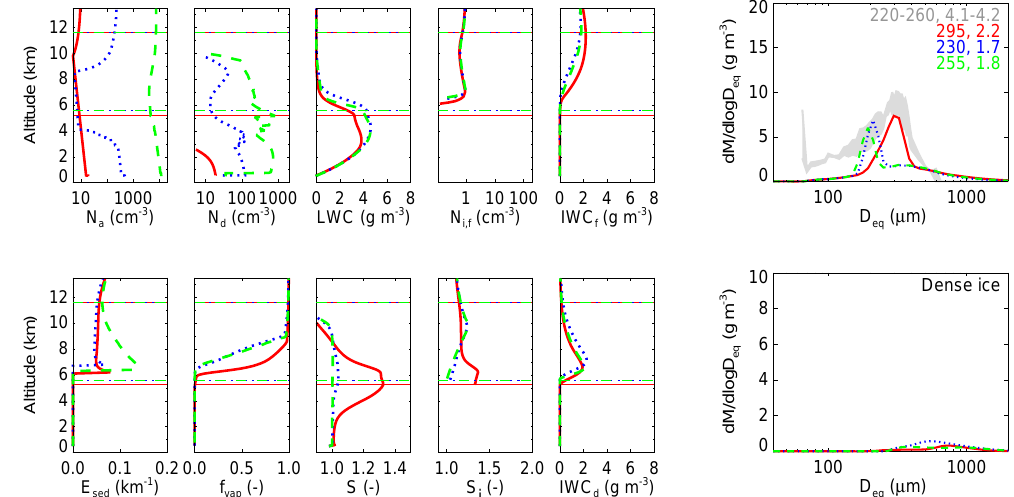
Figure 19. As in Fig. 16, except first panel is profile of total aerosol number concentration ( N a ), for simulations with initial and entrained aerosol number concentrations scaled by factors of 1 / 25 (red solid line), 1 (blue dotted line), and 25 (green dashed